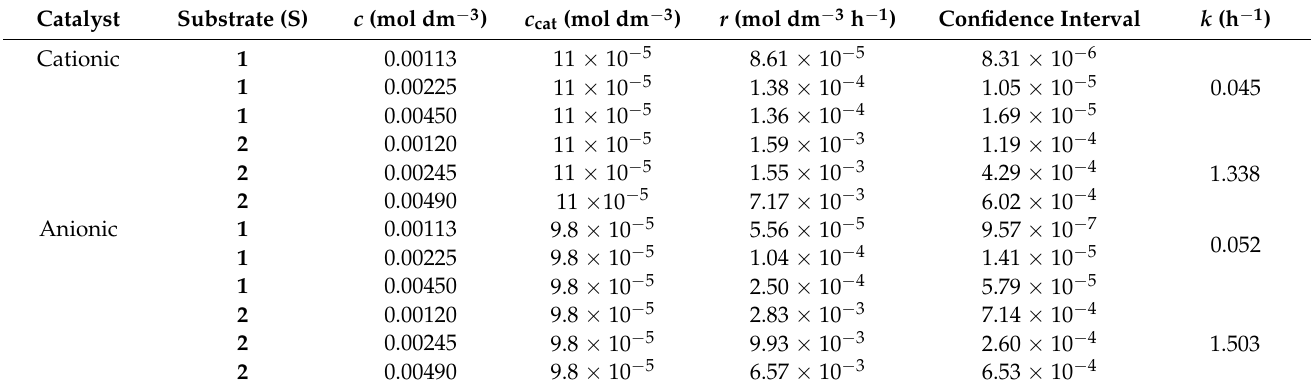
Table 1. Reaction rates and rate constants of selected reactions.